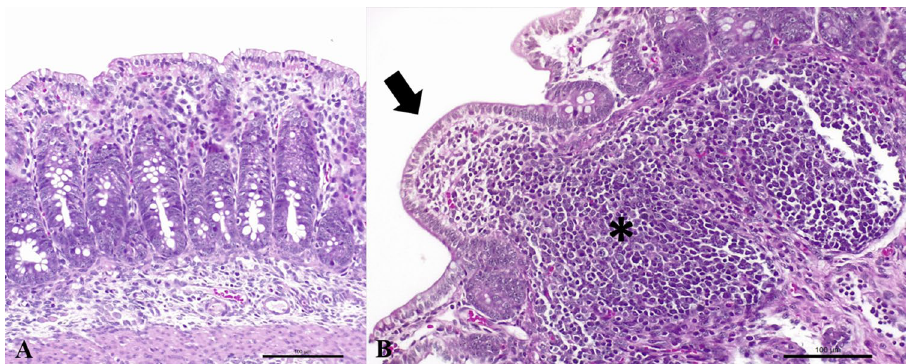
Figure 1. Histopathological findings in jejunum observed in newborn piglets naturally infected by Rotavirus B. (A) Observed marked atrophic enteritis with villous atrophy and blunting. (B) Severe atrophic enteritis with villous fusion (arrow) and hyperplasia of Peyer patches (asterisk). Hematoxylin & Eosin stain. Bar, (A,B) 100 μm. Magnification, ×